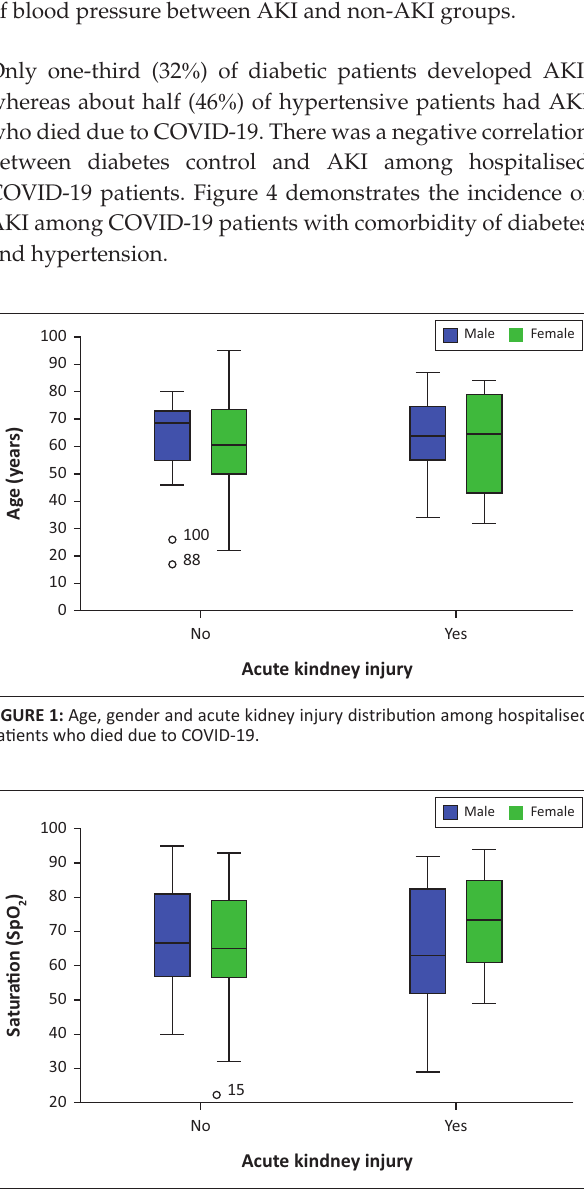
FIGURE 2: Oxygen saturation, gender and acute kidney injury distribution among hospitalised patients who died due to